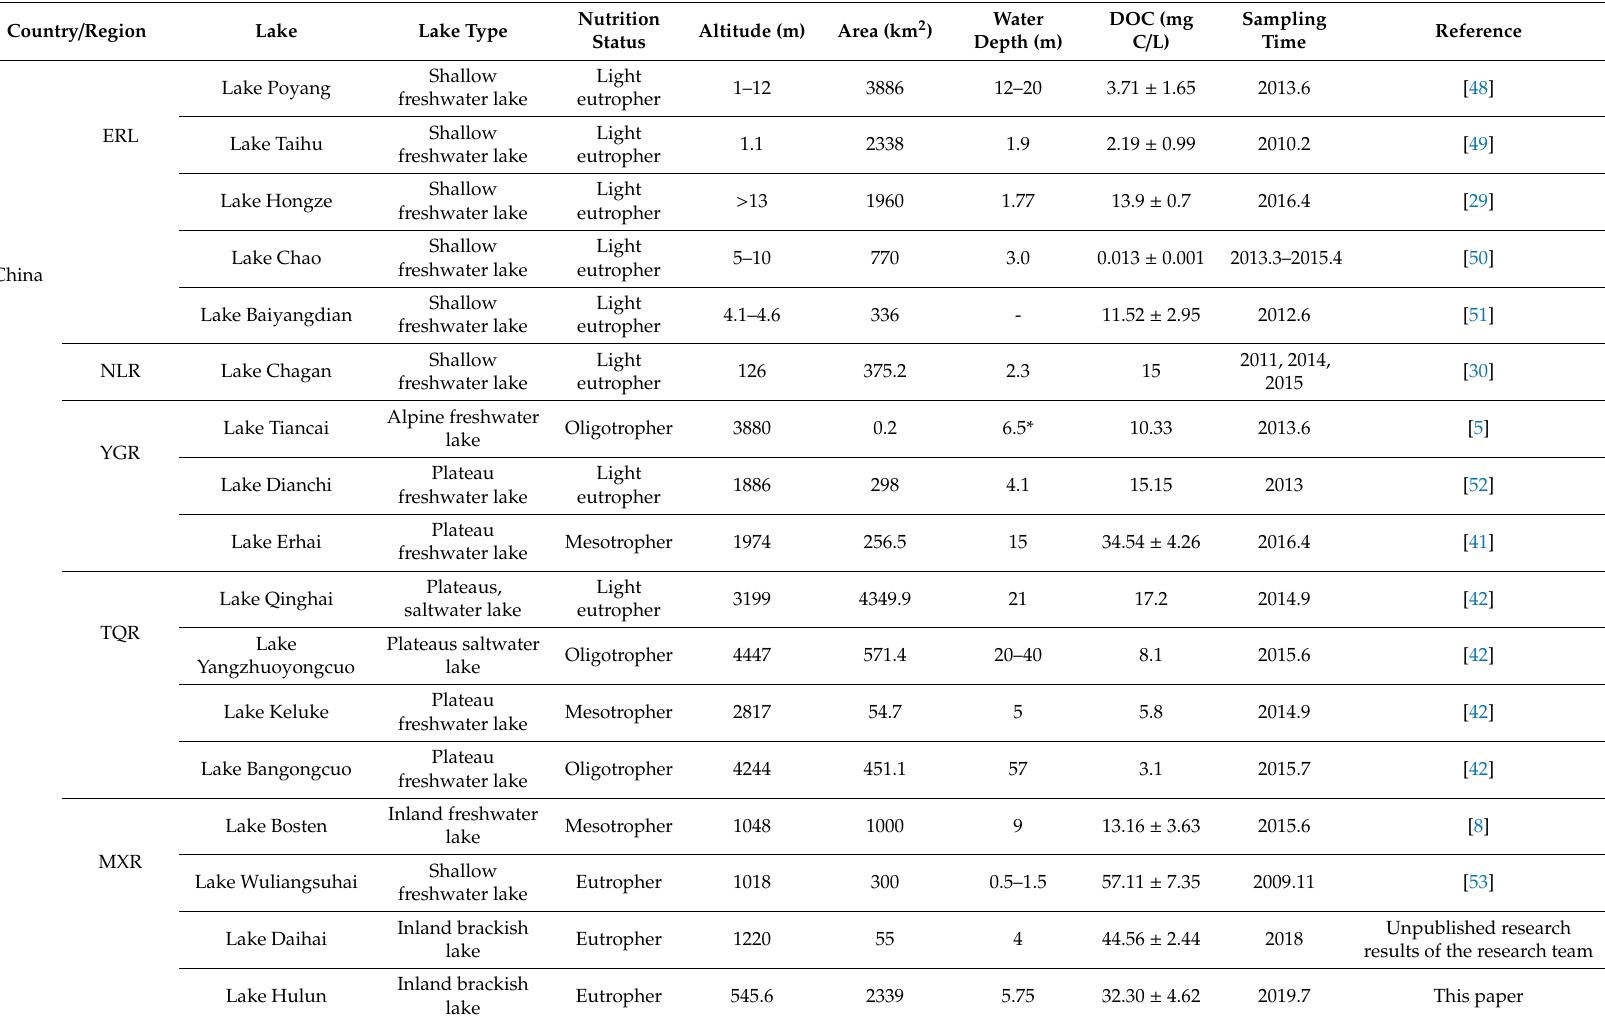
Table 3. Comparison of DOM concentration in Lake Hulun and other